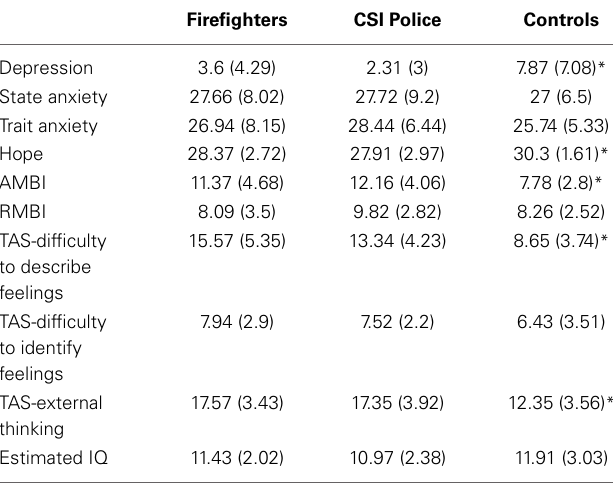
Table 4 | Self-report questionnaires and cognitive assessment (Means and Standard Deviation) of trauma-exposed firefighters, CSI police and trauma unexposed matched